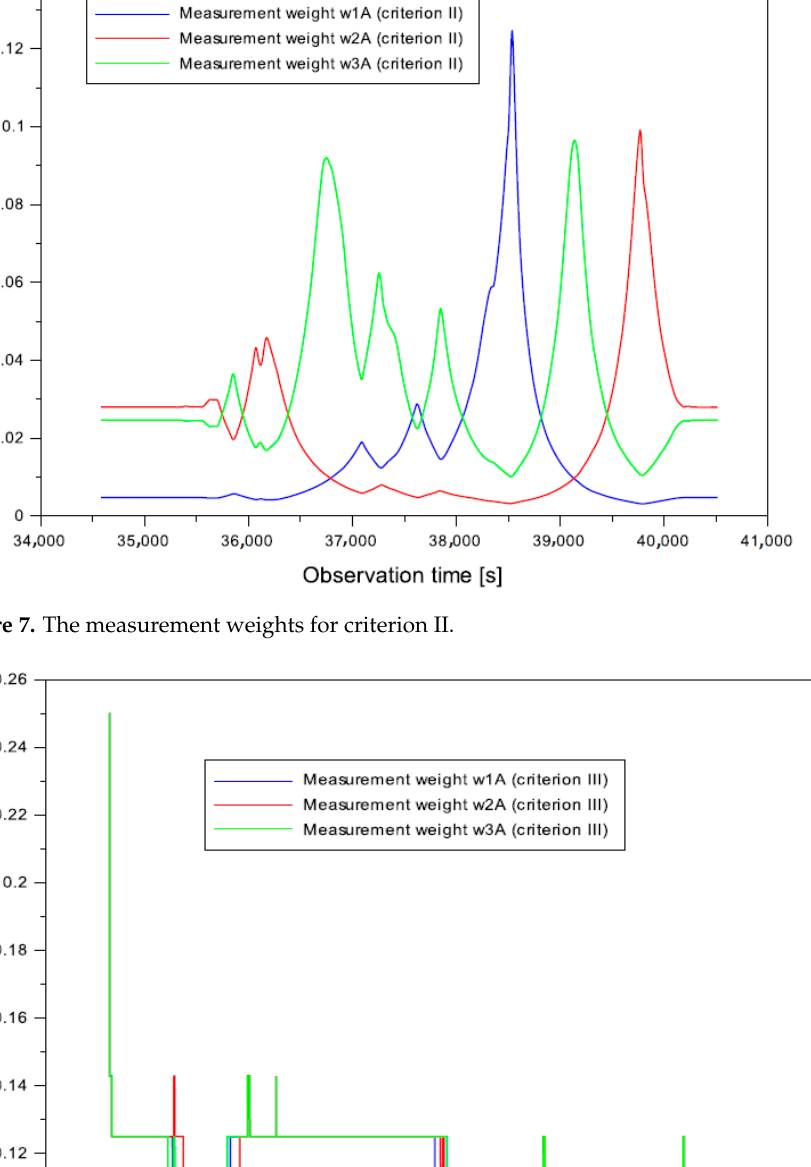
Figure 6. The measurement weights for criterion I.